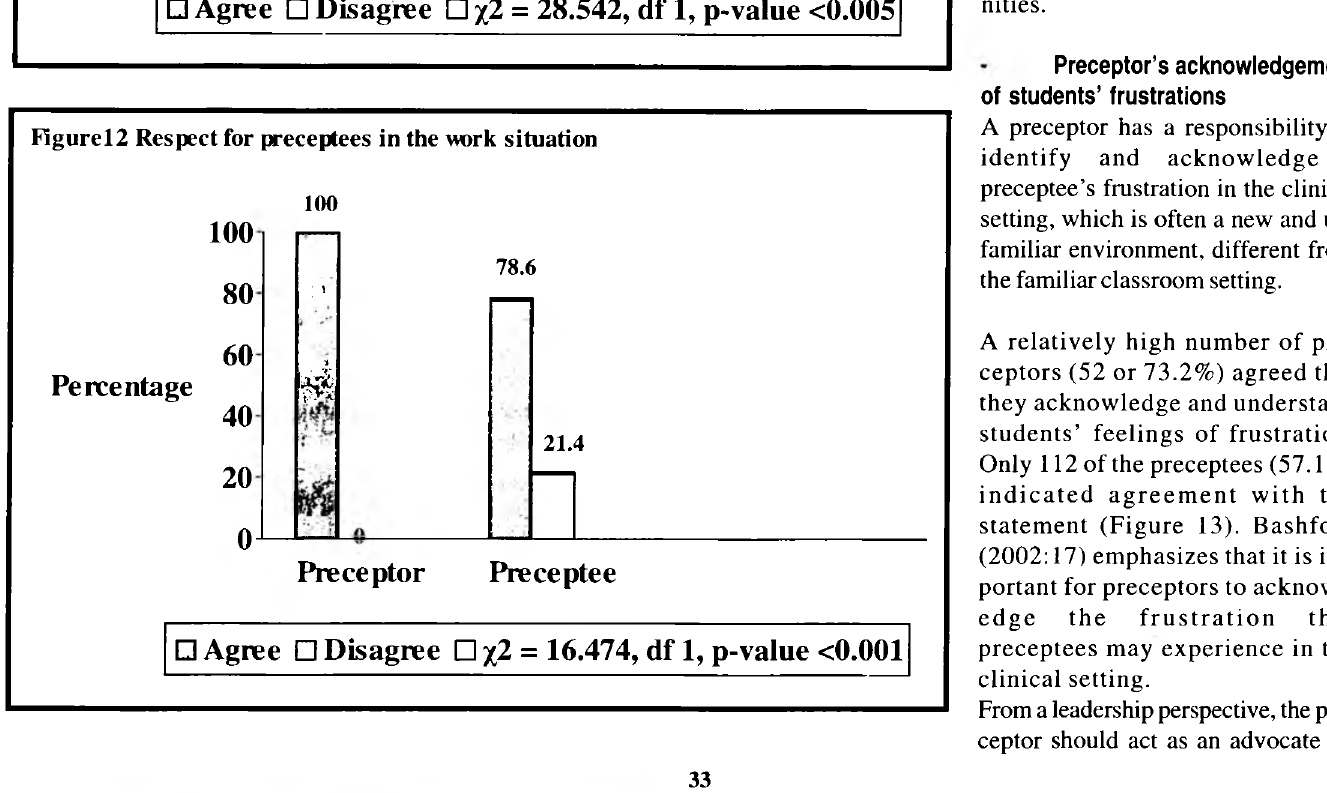
Flgurel2 Respect for preceptees in the work situation